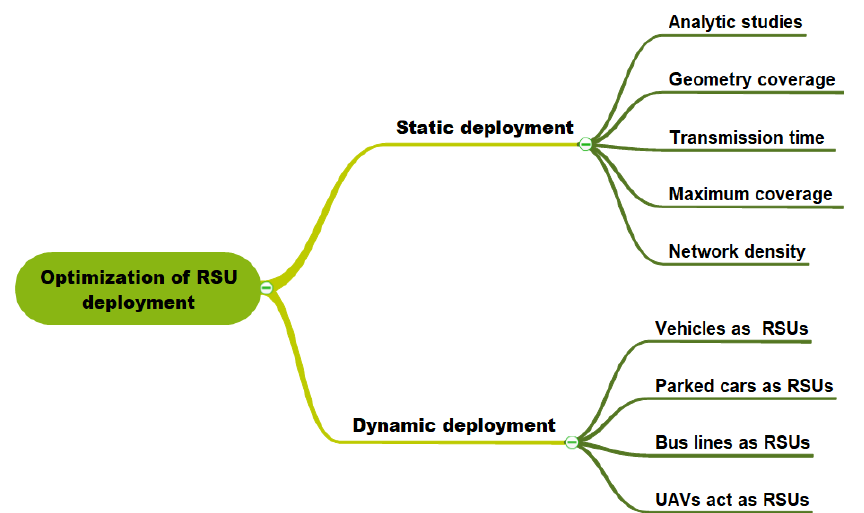
Figure 2. Taxonomy of RSU